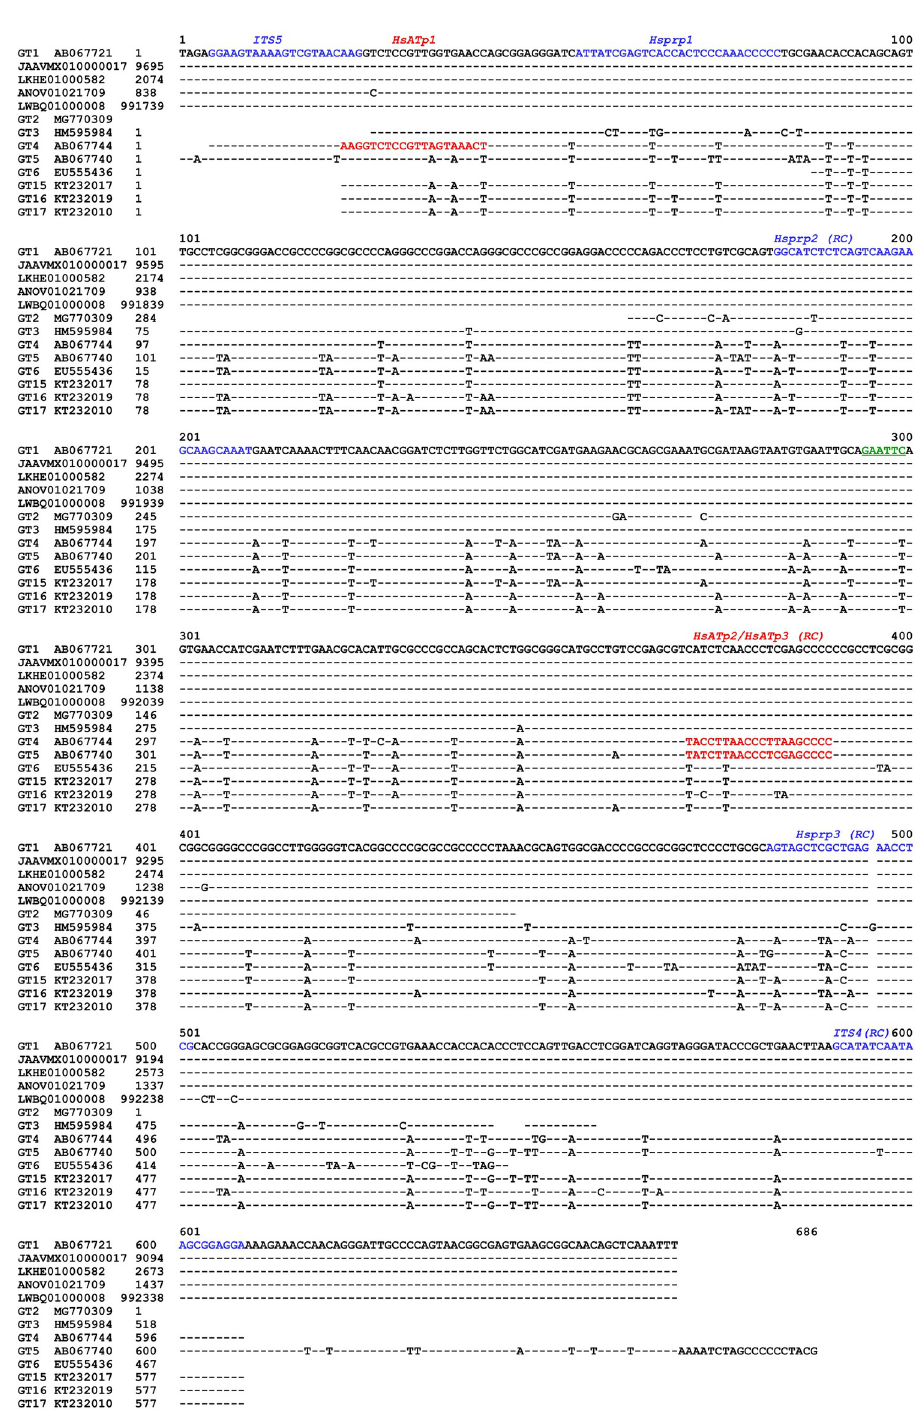
Fig 2. Alignment of the ITS sequences of GC- and AT-biased genotypes of O . sinensis with multiple transition point mutations. GT represents genotype. Genotypes #1–3 are GC-biased O . sinensis genotypes, and Genotypes #4–6 and #15–17 are AT-biased O . sinensis genotypes. The sequence segments shown in blue correspond to the primers designed based on the sequences of GC-biased genotypes, and those in red correspond to primers designed based on the sequences of AT-biased genotypes. The underlined “GAATTC” site shown in green is the enzymatic site of the Eco RI endonuclease, and it is present in the GC-biased sequences at nucleotides 294–299 in Genotype #1 but absent in the AT-biased sequences due to a single-base mutation (GAATTT). “(RC)” denotes the reverse complement sequence of the primers; “-” represents identical bases; and spaces indicate unmatched sequence